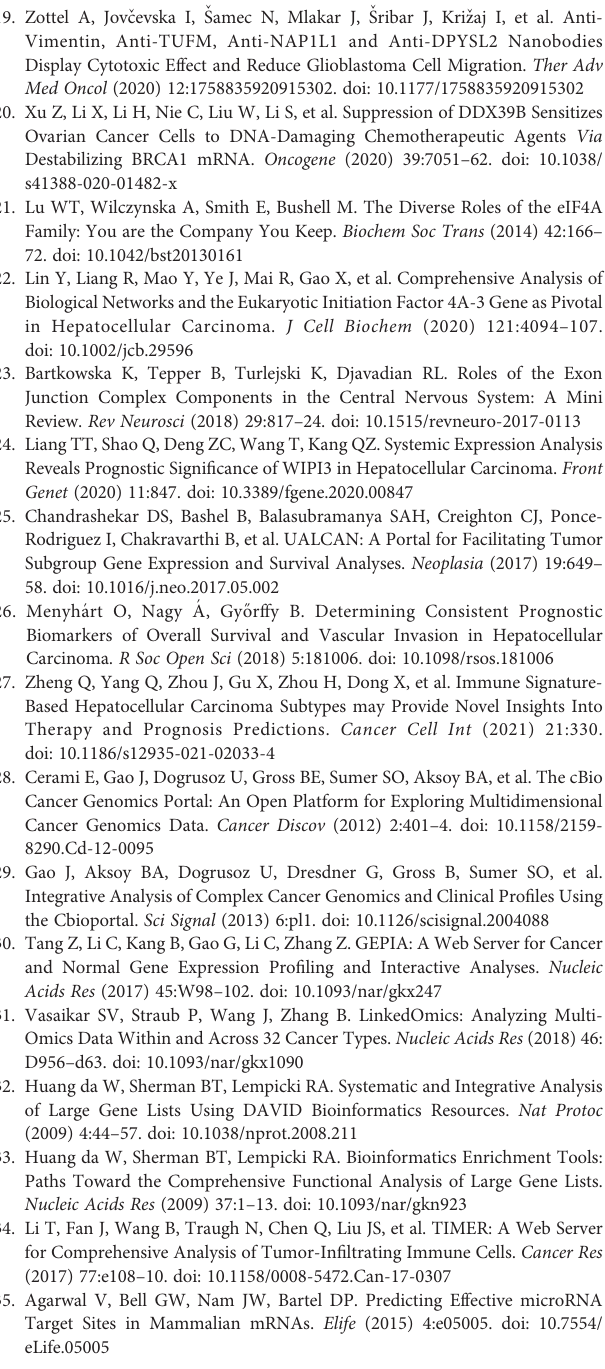
speci fi c groupings were based on TP53 mutation status, race, clinical staging, and clinical grading. (G) The beta values for eIF4A3 mRNA expression in primary liver cancer and in normal samples. (H) A Kaplan-Meier analysis showed that high eIF4A3 expression indicated poor prognosis compared to low eIF4A3 expression. Supplementary Figure 3 | A prognosis analysis based on the eight hub genes. (A – H) An overall survival analysis using the eight hub genes ( BIRC5 , MCM2 , MCM 3, MCM6 , NOP56 , PCNA , RFC4 , and SNRPD1 ) showed that their high expressions were associated with poor prognosis compared to their low-expression